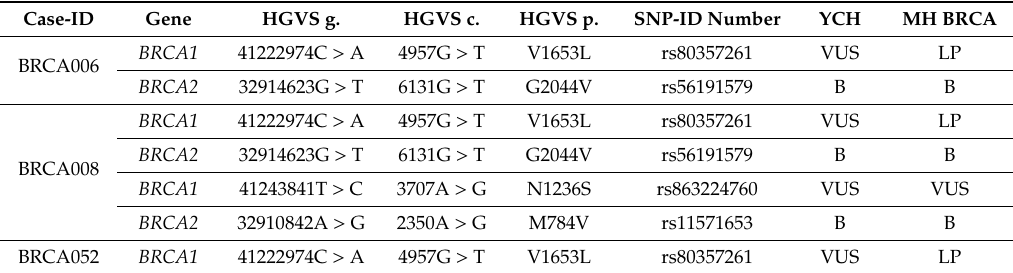
Figure 4. Clinical evaluation of MH BRCA. ( A ) Interpretations of 84 BRCA1 / 2 variants clinically assessed at the Yamanashi Central Hospital (YCH) were compared with the results of MH BRCA classifications. 5-Tier system classification is shown in percentage. ( B ) Blotted classification-matrix illustrates concordance (green) and discordance of clinical significance (red). ( C ) Percentage of concordance in each cluster. ( D ) Predicted response to PARP inhibition in the MH Guide of 84 BRCA1 / 2 variants is based on the functional impact of neutral, hypermorphic, or hypomorphic variants in homologous recombination activity and pathomechanism. ( E ) Cluster analysis of MH BRCA classified variants with a predicted response to PARP inhibition in MH Guide within the sub-categories. Abbreviations: P = pathogenic; LP = likely pathogenic; VUS = variant of unknown significance; LB = likely benign; B = benign. Table 1. Case analysis of clinically relevant discordant BRCA1 / 2 classification in MH BRCA. The BRCA1 variant p.V1653L (rs80357261) was reclassified as likely pathogenic in MH BRCA and found in blood samples of 3 patients without any additional pathogenic germline BRCA1 / 2 variant, which might be indicative for predisposition to HBOC